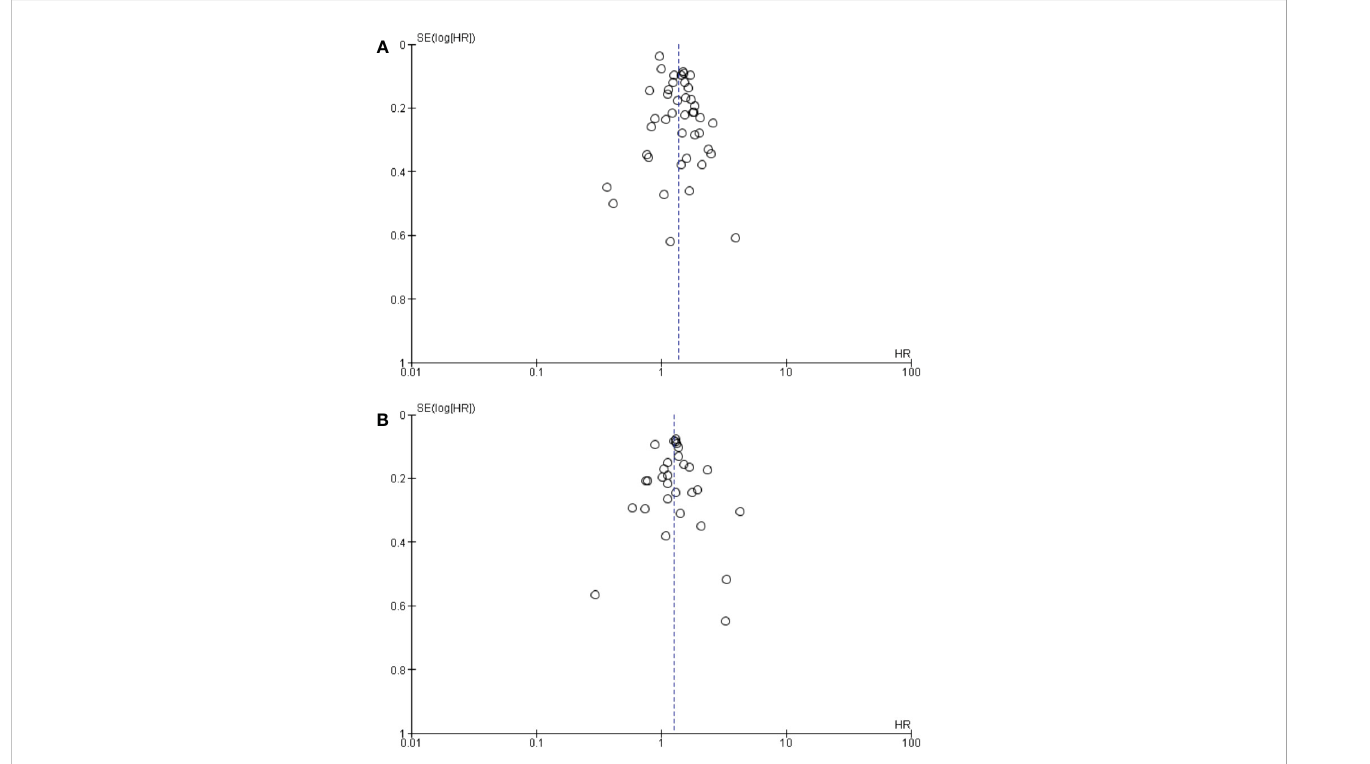
FIGURE 3 Begg ’ s funnel plot of HR ratios of (A) OS and (B) PFS. HR, hazard ratio; SE, standard